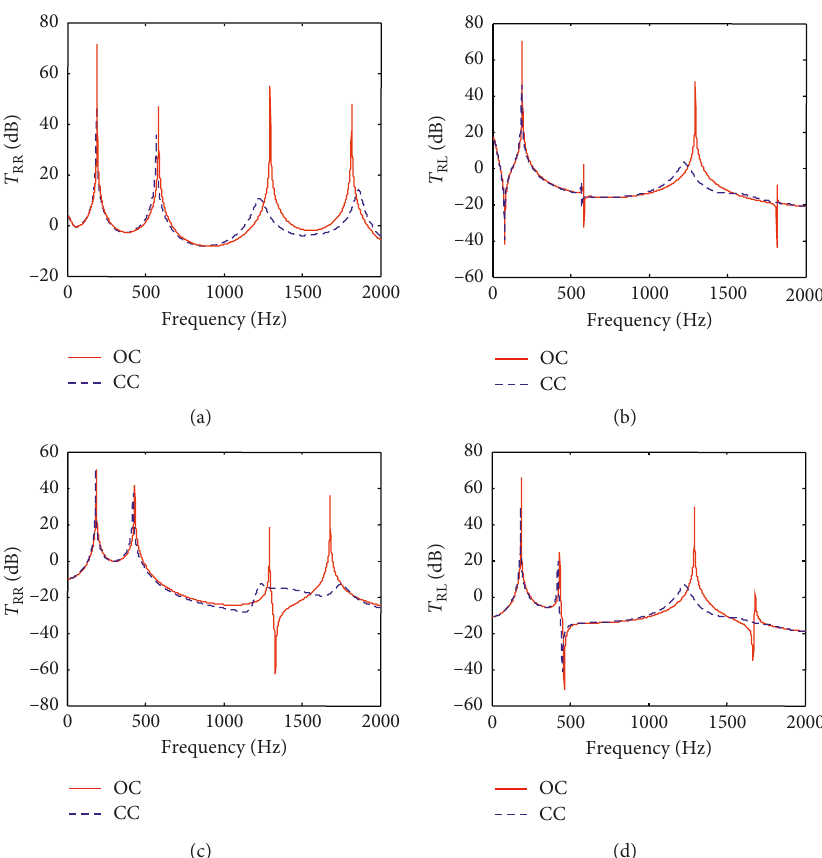
Figure 13: Mode conversion from flexural to longitudinal waves with open circuits (OC) and closed circuits (CC, L � 0.4 H and R � 800 Ω